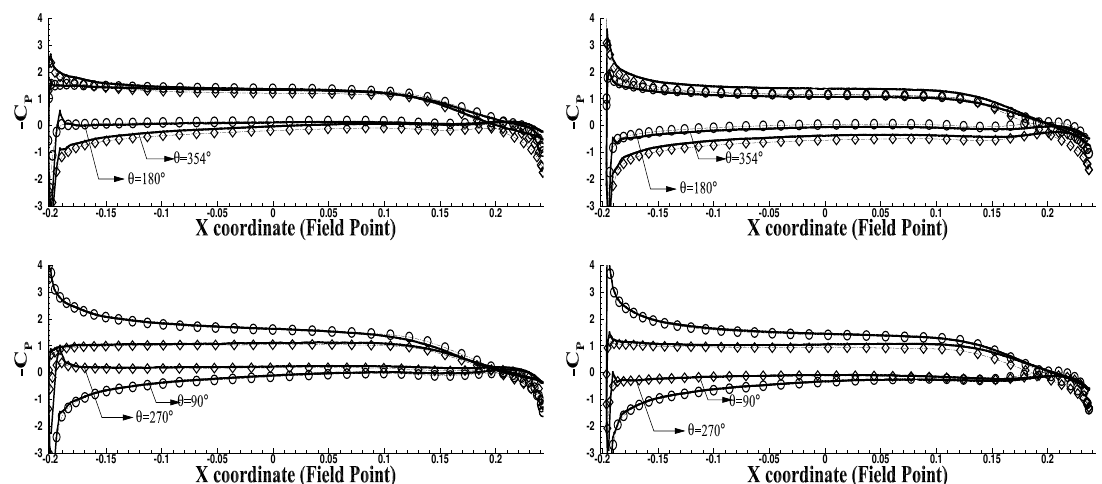
Figure 14. Key-blade surface pressures at the four different time steps at r / R = 0.56 ( left ) and r / R = 0.75 ( right ). Comparisons between RANS (solid line) with BEM (symbols) in 10 ◦ inclined shaft flow for DTMB 4661 propeller: J S =